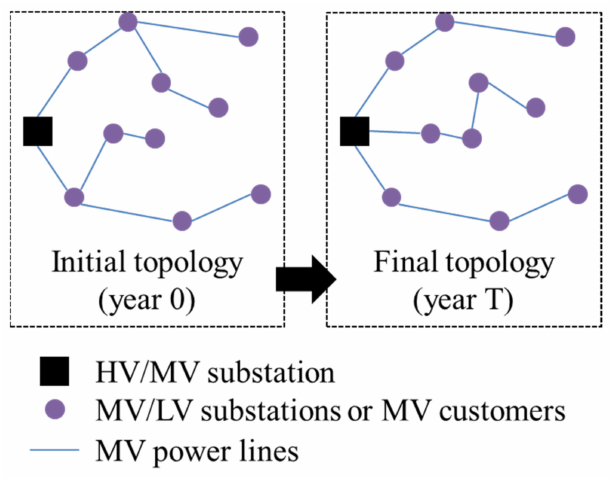
Figure 2. Network evolution between today and year T